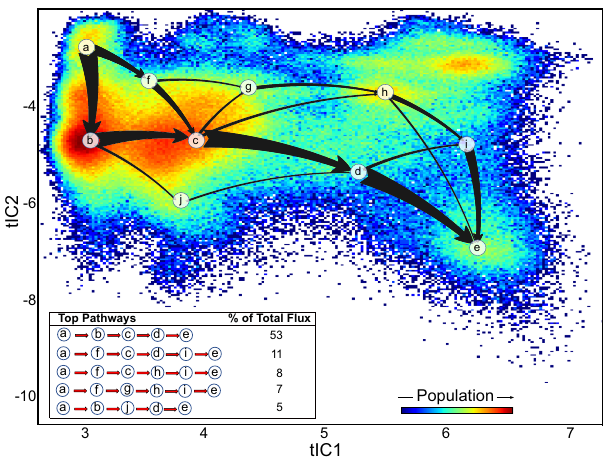
Fig. 4 Kinetic pathways leading to groove opening states and destabilization of the distal Ca 2 + ion at the dimer interface. The top 5 pathways identi fi ed from the TPT analysis to connect macrostate a (closed TM4 – TM6 interface, closed TM4 – TM2 interface, stably bound Ca 2 + ion) to macrostate e (fully open TM4 – TM6 and TM4 – TM2 interfaces, destabilized Ca 2 + ion) are identi fi ed in the table insert and represented by the arrows overlaid on the 2D space of the fi rst two tIC vectors (see “ Methods ” and also Fig. S9 for macrostate assignment). The thickness of the arrows indicates the relative magnitude of the fl ux of the pathway. The relative contributions of the top pathways to the total fl ux values are given in the